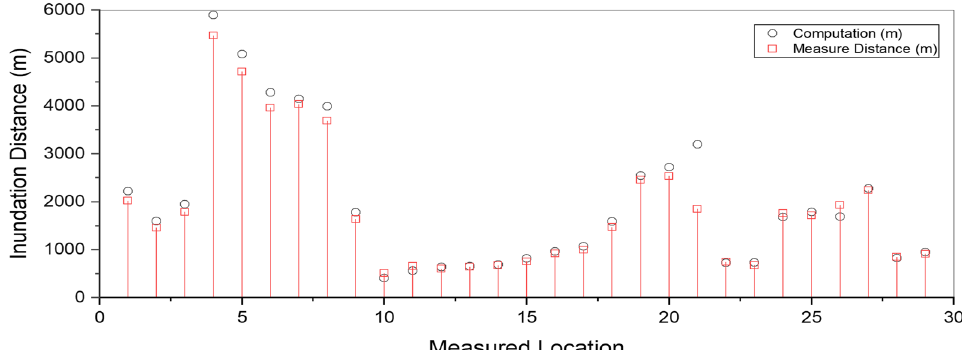
Fig. 6 Comparison between computation and measured inundation distance